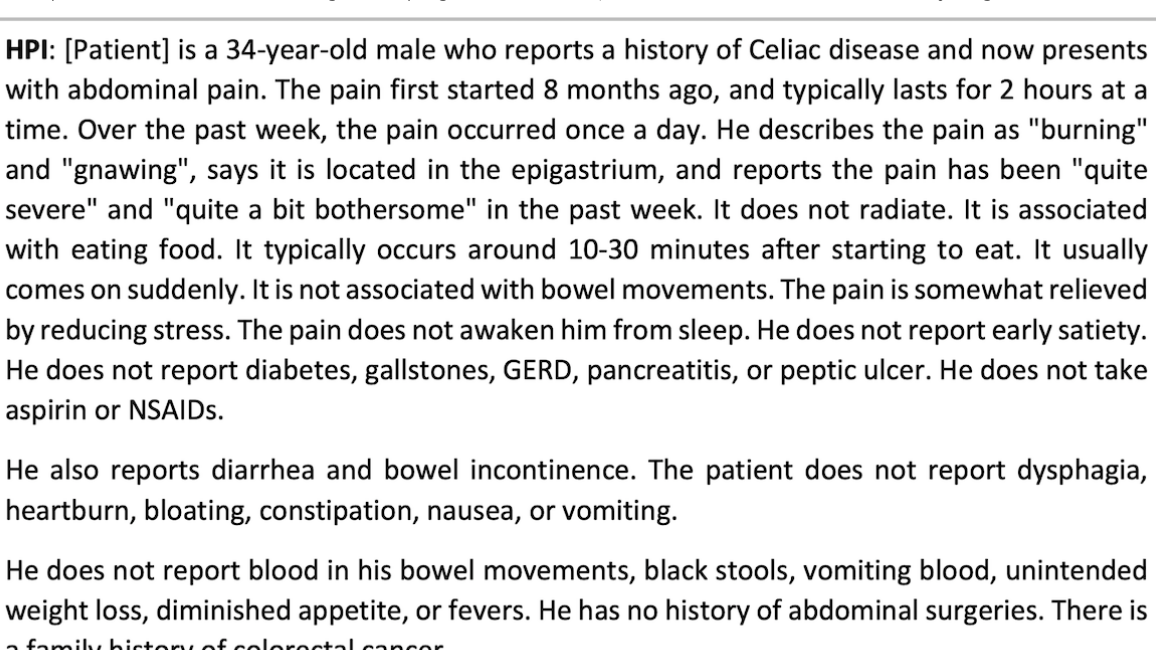
Figure 1. Sample Automated Evaluation of Gastrointestinal Symptoms (AEGIS) history of present illness (HPI) [3], which was composed entirely by the AEGIS software and based on the patient’s responses to questions about their gastrointestinal symptoms; then, the HPI is uploaded into the electronic health record where the physician can review it prior to seeing the patient as well as copy the HPI into their consult note and modify it as needed based on the subsequent clinical encounter. GERD: gastroesophageal reflux disease; NSAID: nonsteroidal anti-inflammatory